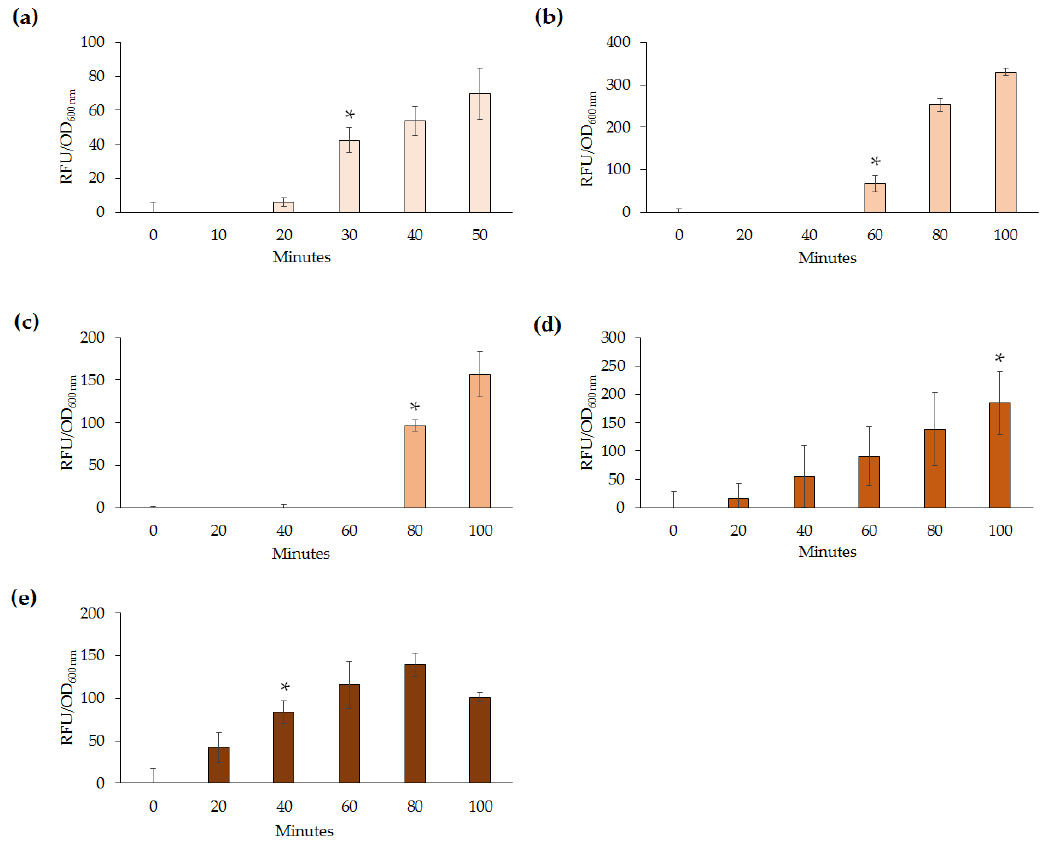
Figure 4. The time taken until a detectable response was determined for the five lead biosensors was found to range between 30 and 100 min after the addition of varying concentrations of Pb(II) (* p < 0.05). The p -value indicates the earliest significant increase in RFU per OD 600 nm , in comparison to the time point 0 after induction with Pb(II). ( a ) E. coli DH5 α (pBB pbrRgfp ) (5 µ g · mL − 1 ); ( b ) P. aeruginosa PAO1(pBB pbrRgfp ) (0.2 µ g · mL − 1 ); ( c ) S. oneidensis MR-1(pBB pbrRgfp ) (5 µ g · mL − 1 ); ( d ) Enterobacter sp. NCR3(pBB pbrRgfp ) (2 µ g · mL − 1 ); and ( e ) Enterobacter sp. LCR17(pBB pbrRgfp ) (5 µ g · mL − 1 ). Note: For S. oneidensis MR-1(pBB pbrRgfp ) only one biological replicate is shown. For Enterobacter